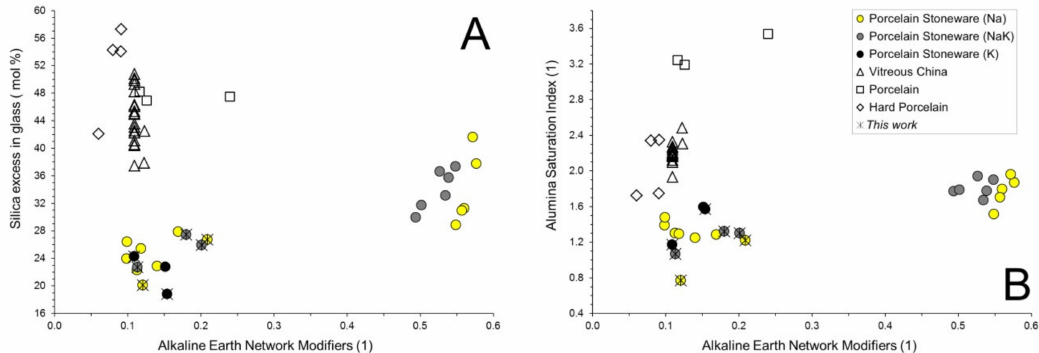
Figure 5. Chemical composition of the vitreous phase in porcelain-like materials. Fraction of alkaline earth on the total amount of Glass Network Modifiers calculated on mol % (MgO + CaO/MgO + CaO + Na 2 O + K 2 O) versus ( A ) silica in excess with respect to a feldspathic melt and ( B ) Alumina Saturation index (calculated on mol